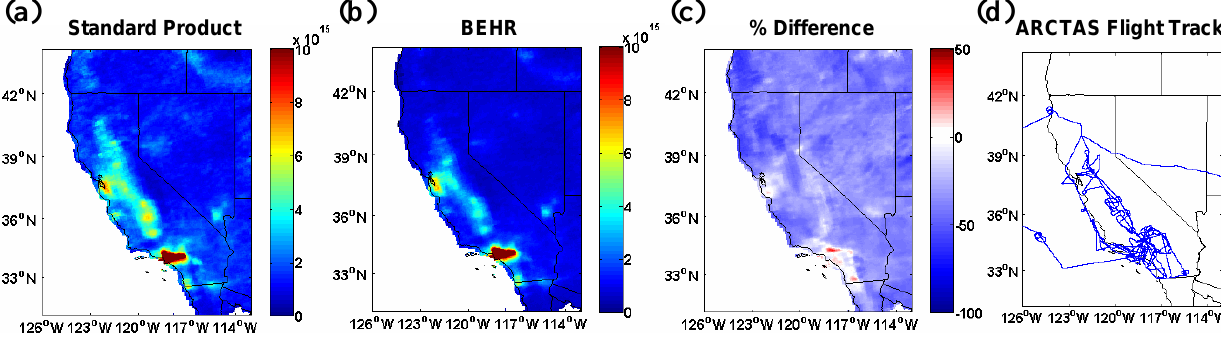
Fig. 4. Average tropospheric NO 2 column for June 2008 from (a) the Standard Product and (b) the BEHR product, and (a) the percent difference between the two products. (a) Flight tracks during the ARCTAS-CA campaign, 18-24 June